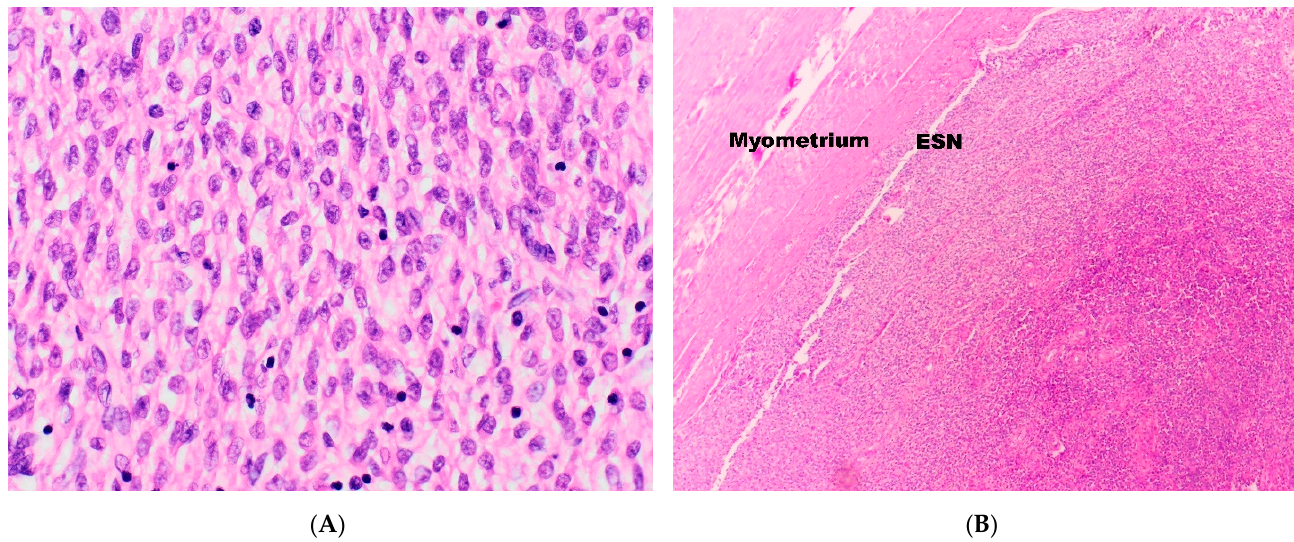
Figure 1. ( A ) Neoplastic cells in Endometrial Stromal Nodules (ESN) and Low-Grade Endometrial Stromal Sarcomas (LG-ESS) resemble endometrial stromal cells in the proliferative phase. ( B ) ESNs show a non-infiltrative margin.